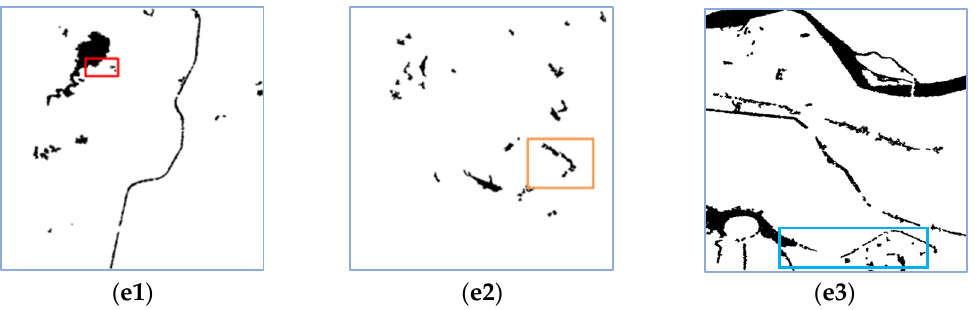
Figure 10. Water extraction results of FFEDN with different combinations in three selected regions. ( a1 )–( a3 ) The results of Combination A. ( b1 )–( b3 ) Results of Combination B. ( c1 )–( c3 ) Results of Combination C. ( d1 )–( d3 ) Results of Combination D. ( e1 )–( e3 ) Results of Combination E.